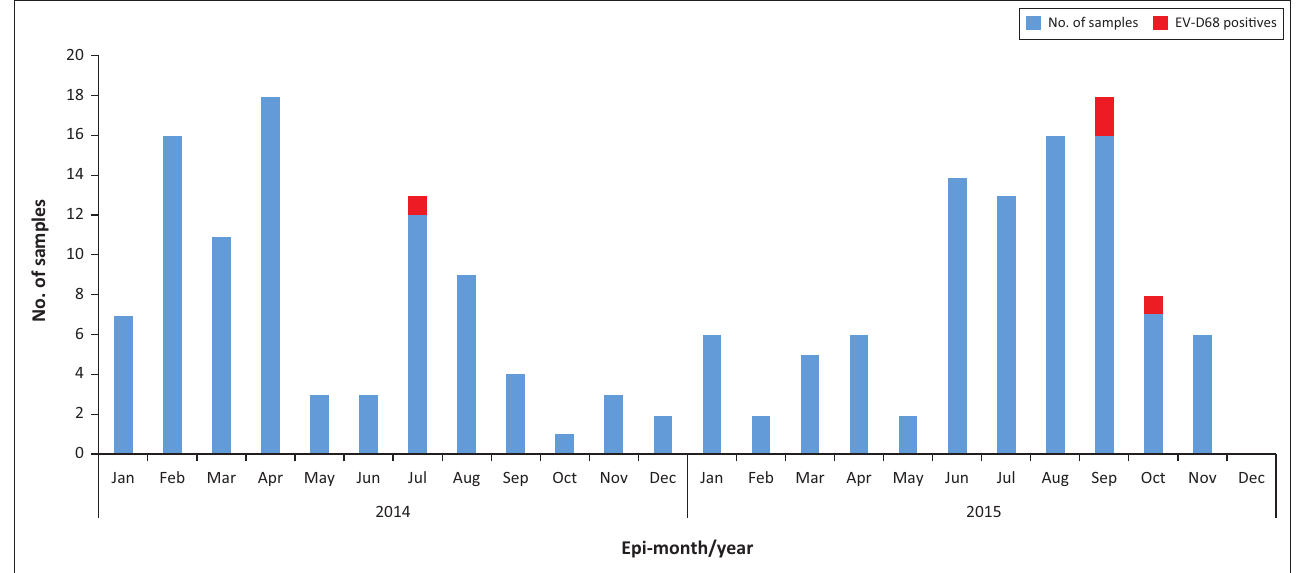
FIGURE 1: Monthly distribution of acute respiratory infection cases investigated. Samples were selected from archived samples of patients with acute respiratory infection received from January 2014 to December 2015. TABLE 1: Enterovirus D68 real-time reverse-transcription polymerase chain reaction panel primer and probe sequences [132]. Primer/probe